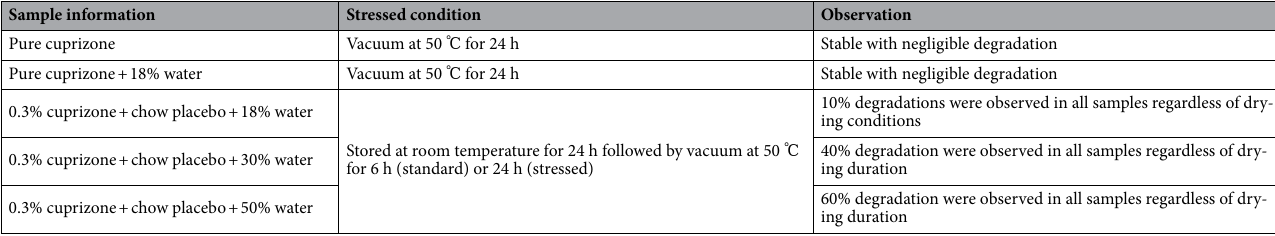
Table 10. Stability of cuprizone in different